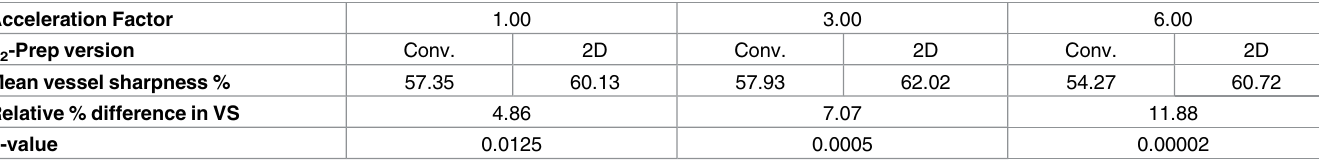
Table 1. Improvement in RCA Vessel Sharpness using the 2D-T2-Prep for R = 1,3, and 6. Acceleration